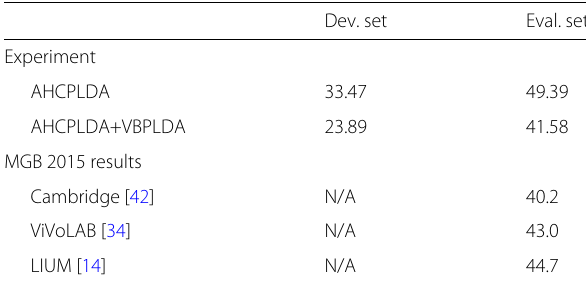
Table 1 DER(%) for the reference system